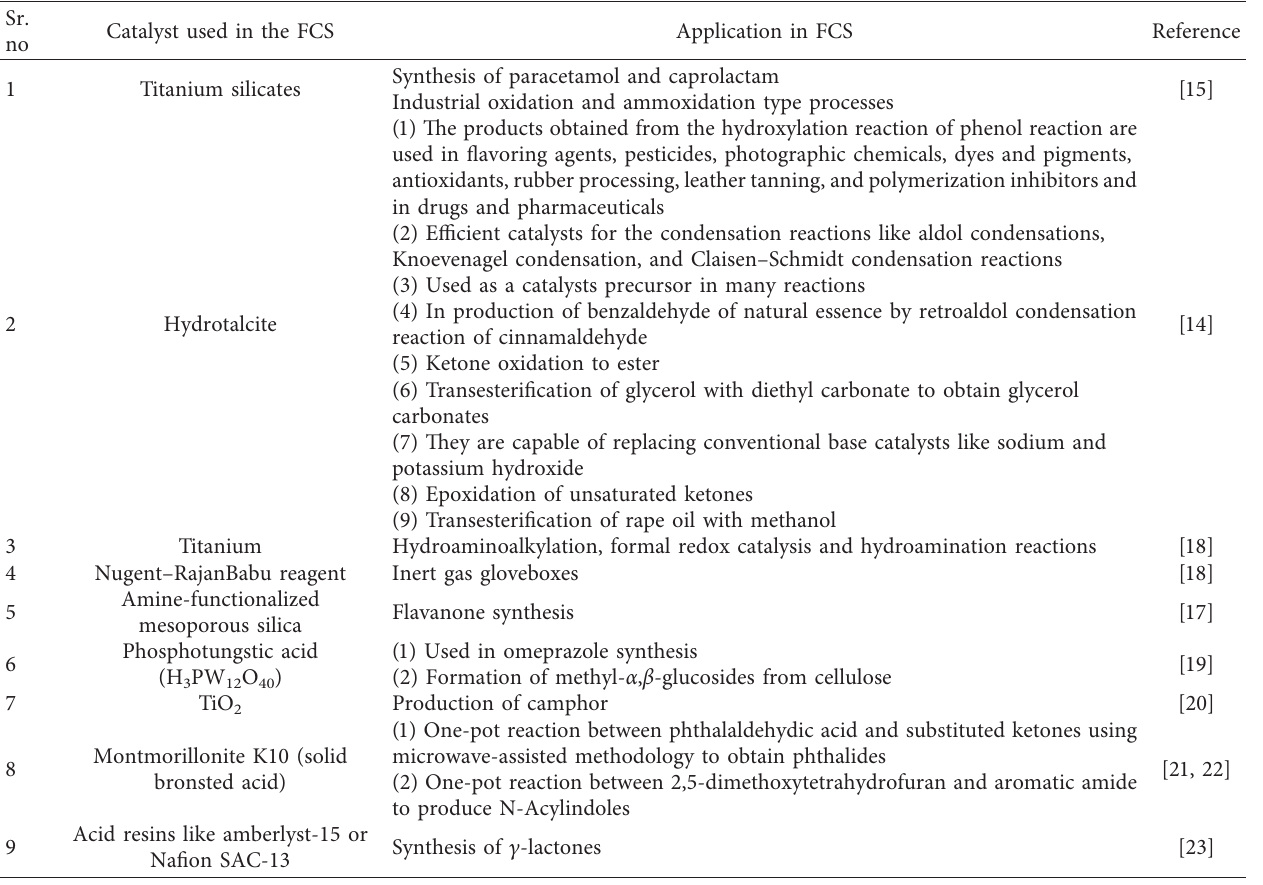
Table 3: Application of some catalysts in fine chemical